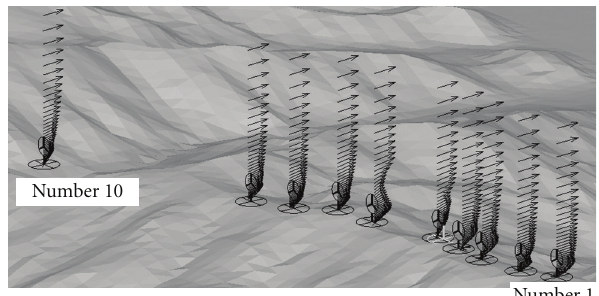
Figure 5: Vertical profile of wind velocity vectors at the location of each turbine. Northerly wind case. Instantaneous values.